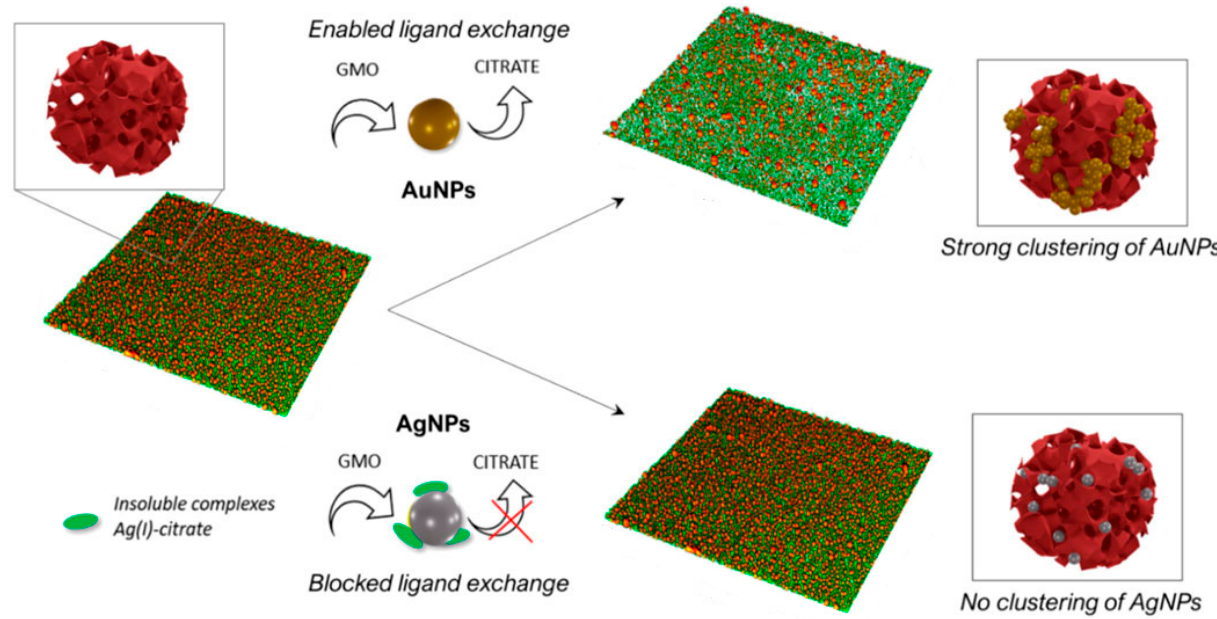
Figure 9. Schematic representation of the mechanism and final outcomes of the interaction of Au NPs and Ag NPs with a water dispersion of cubosomes and solid-supported films of cubosomes. (Reprinted from [34], license CC BY 4.0.)